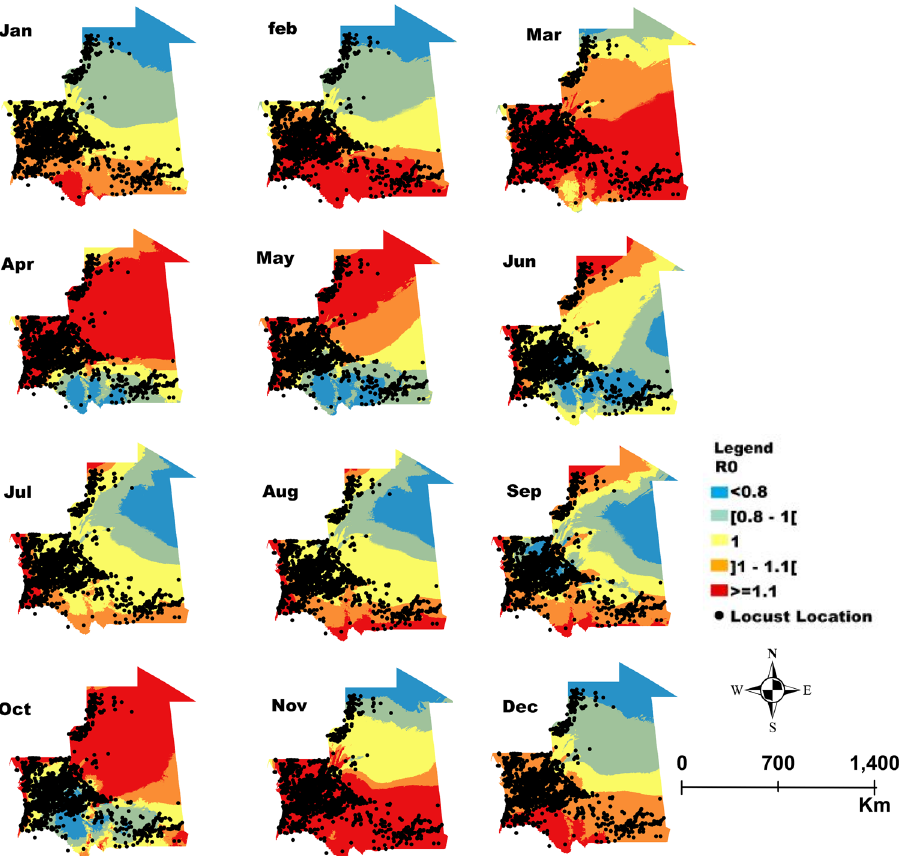
Figure 5. Mauritania: Monthly spatial projection of the variation in R 0 as a function of temperature and relative humidity reflecting the potential efficiency of the entomopathogenic fungus Metarhizium acridum as a biocontrol agent against desert locusts. The area in red in each month are areas where R 0 > 1 correspond to zones with potential higher efficiency and hence fungal biocontrol agent application against locusts while area in orange ( R 0 ≈ 1) can also be targeted but with less potential efficacy. Application in areas in yellow and blue ( R 0 < 1) will probably not be efficient. The dots correspond to the reported point incidence of locusts in